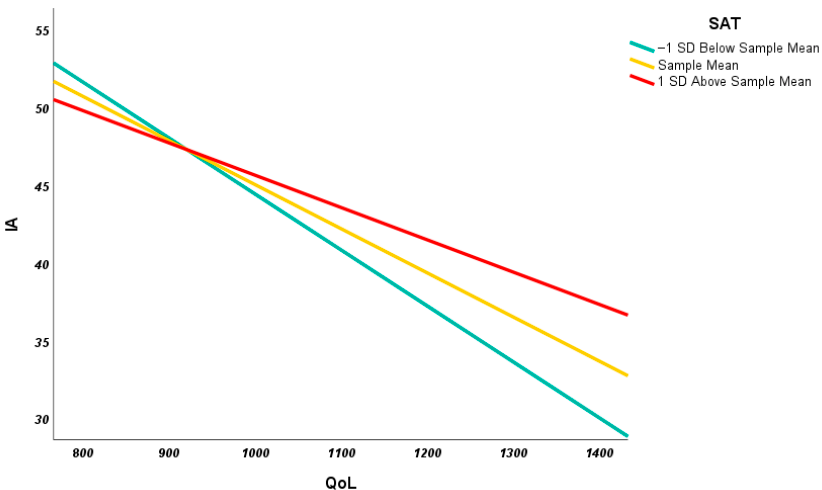
Figure 2. Relationship between QoL and IA at the high, average and low levels of SATs.